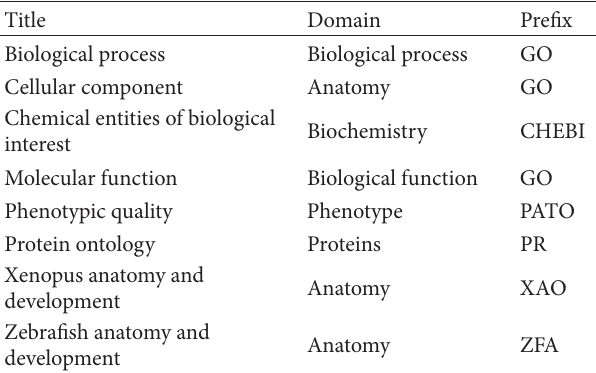
Table 2: Mature ontologies in